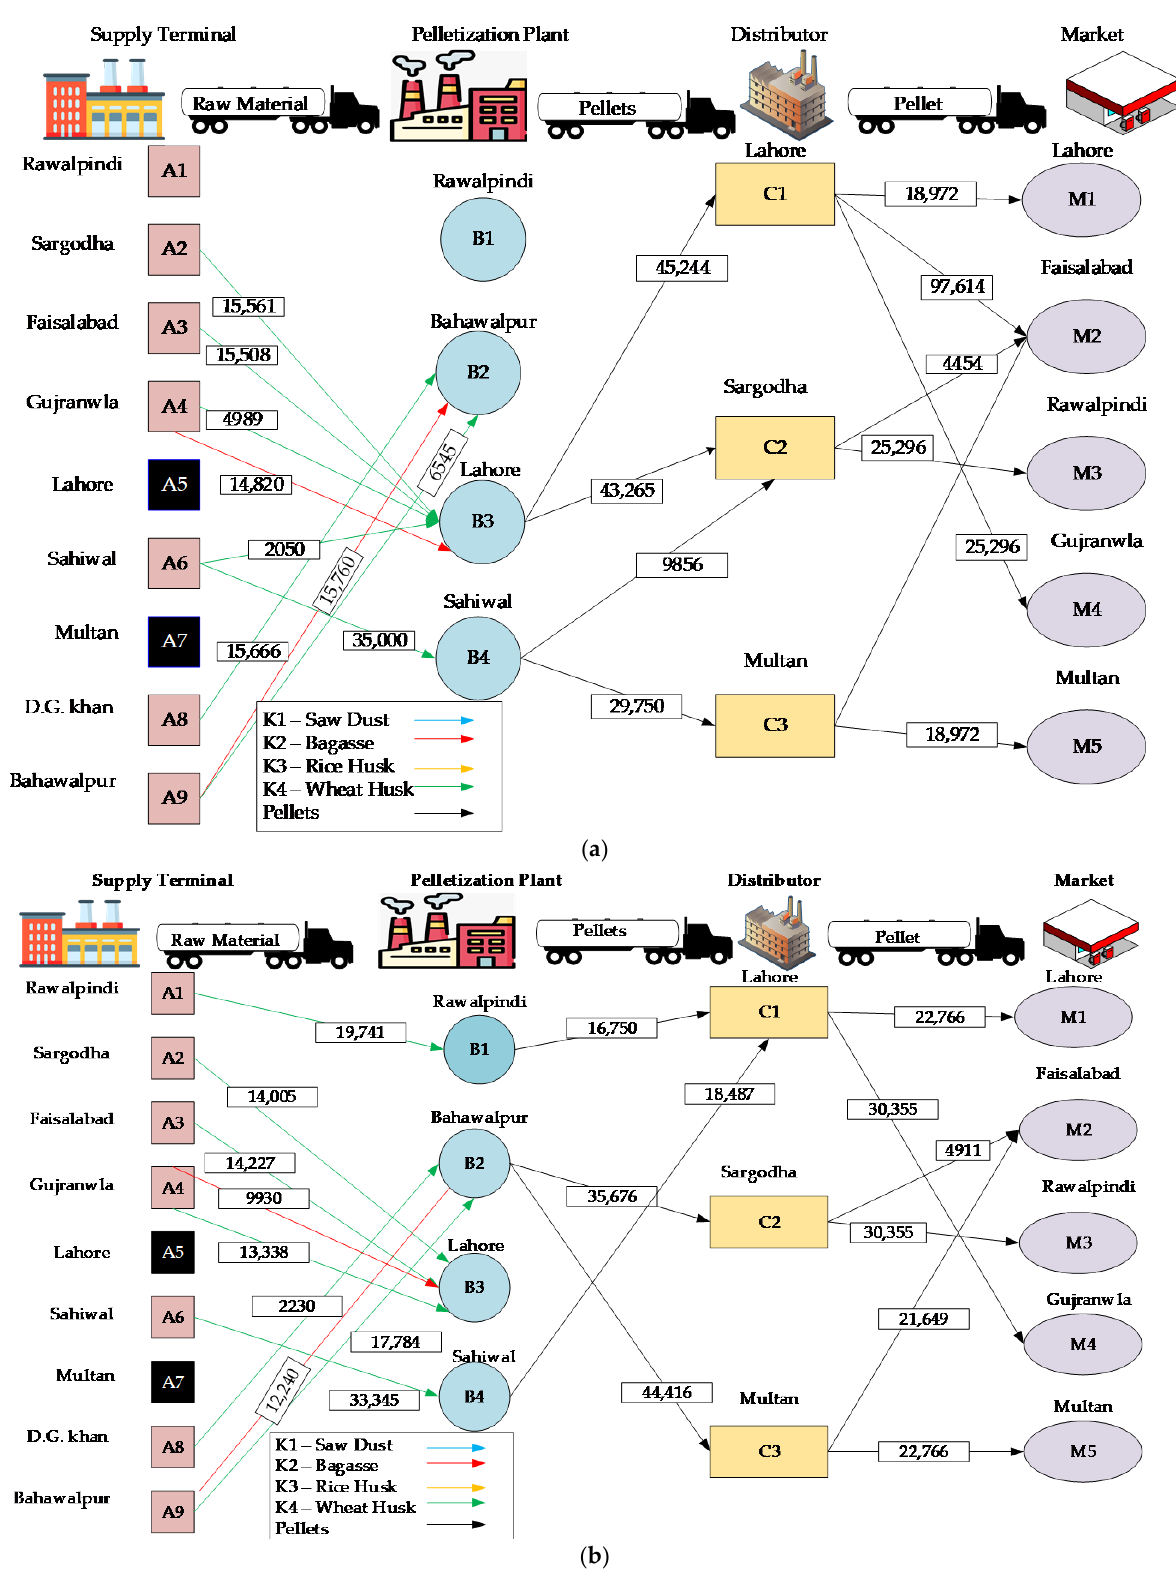
Figure 4. WPP-SCND model decisions using fuzzy-FRPP during ( a ) first time period t 1 ( b ) second time period t 2 .